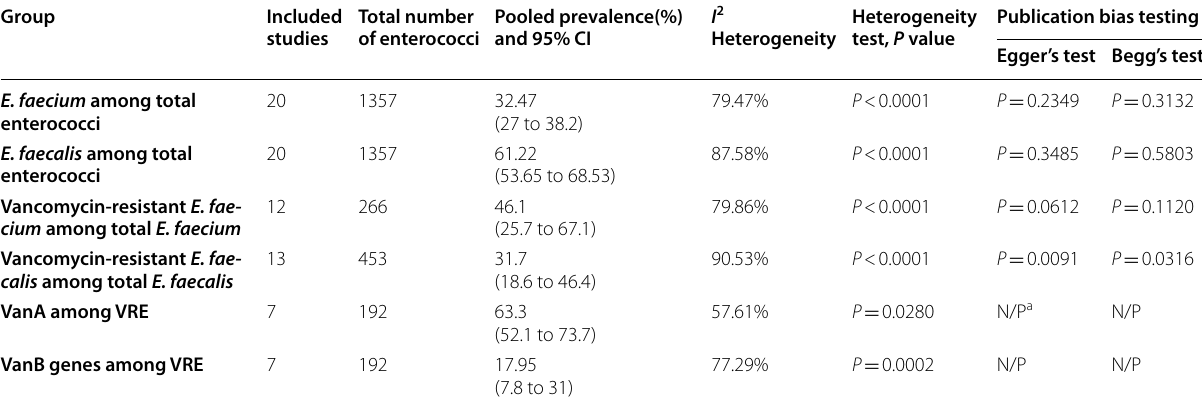
Table 2 Pooled prevalence of E. faecium and E. faecium among enterococci, their Vancomycin resistance and VanA and VanB genes among